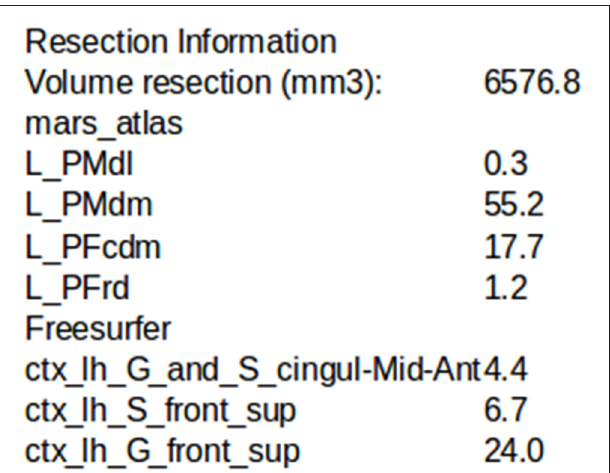
coregistration routines. All transformation matrices are saved